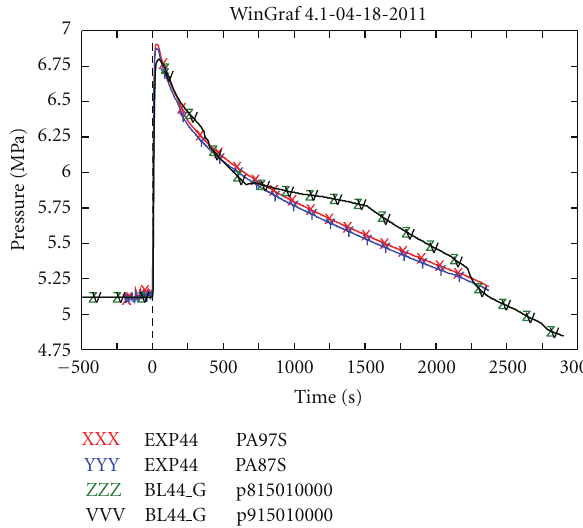
Figure 13: Secondary system